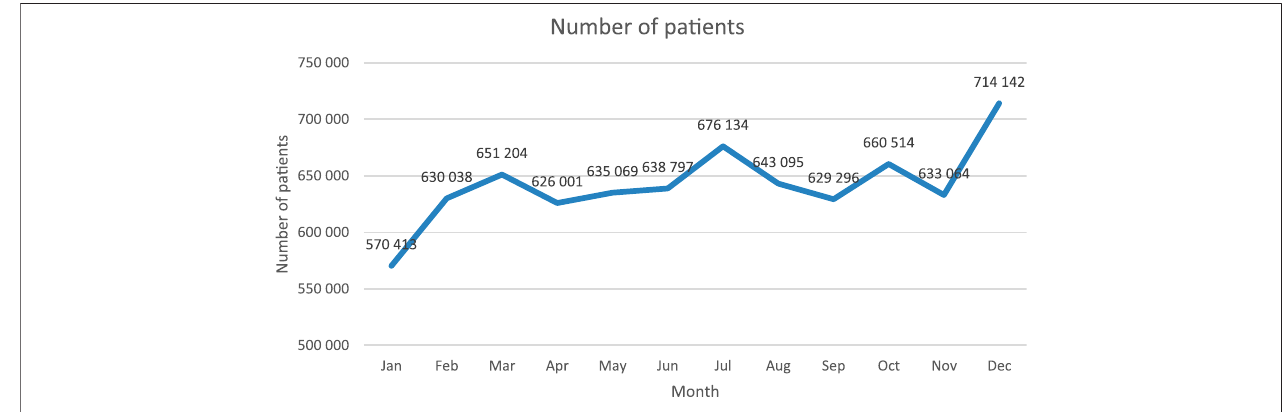
TABLE 1 | Detailed characteristics of a group of Polish elderly patients who were identi fi ed to be a subject of chronic polypharmacy in 2018. Parameter N % Elderly people on chronic polypharmacy